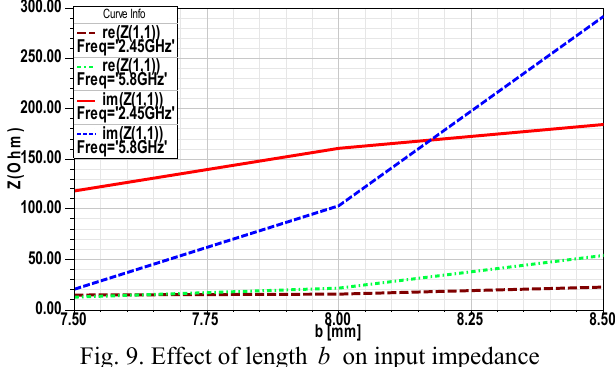
Fig. 9. Effect of length b on input impedance